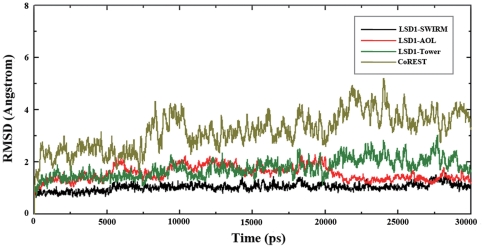
Time dependencies of the weighted root-mean-square deviations for the backbone atoms of the three domains of LSD1 and CoREST from their initial positions during the 30-ns simulation.